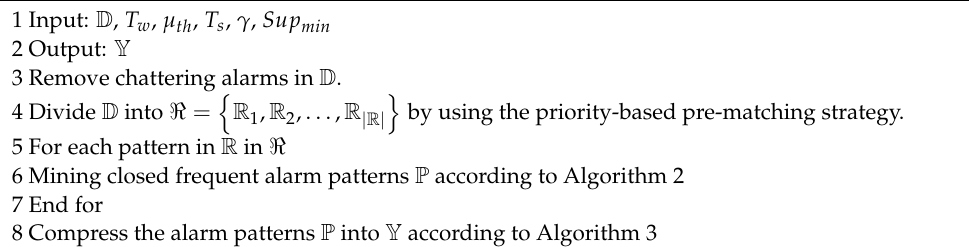
Algorithm 4 Mining closed frequent alarm patterns in